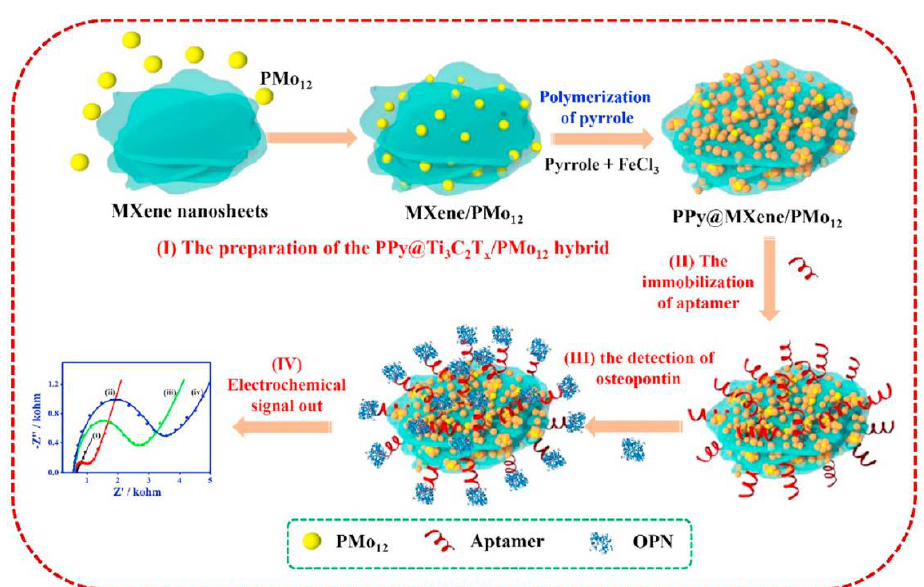
Figure 5. Schematic representation of the fabrication of the aptasensor for OPN based on the PPy@Ti 3 C 2 T x /PMO 12 hybrid: (I) the preparation of PPy@Ti 3 C 2 T x / PMo 12 , (II) the aptamer immobilisation, (III) the OPN detection, and (IV) the electrochemical signal read-out [135]. Copyright (2019) Elsevier, reprinted with permission.